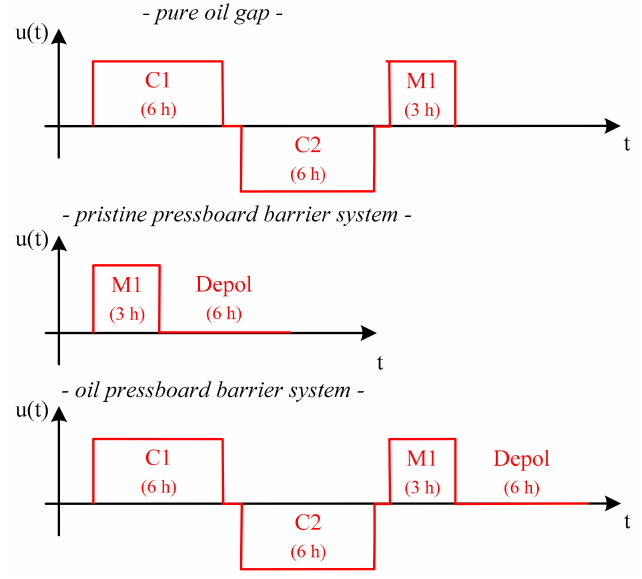
Figure 3. Voltage application for various barrier system